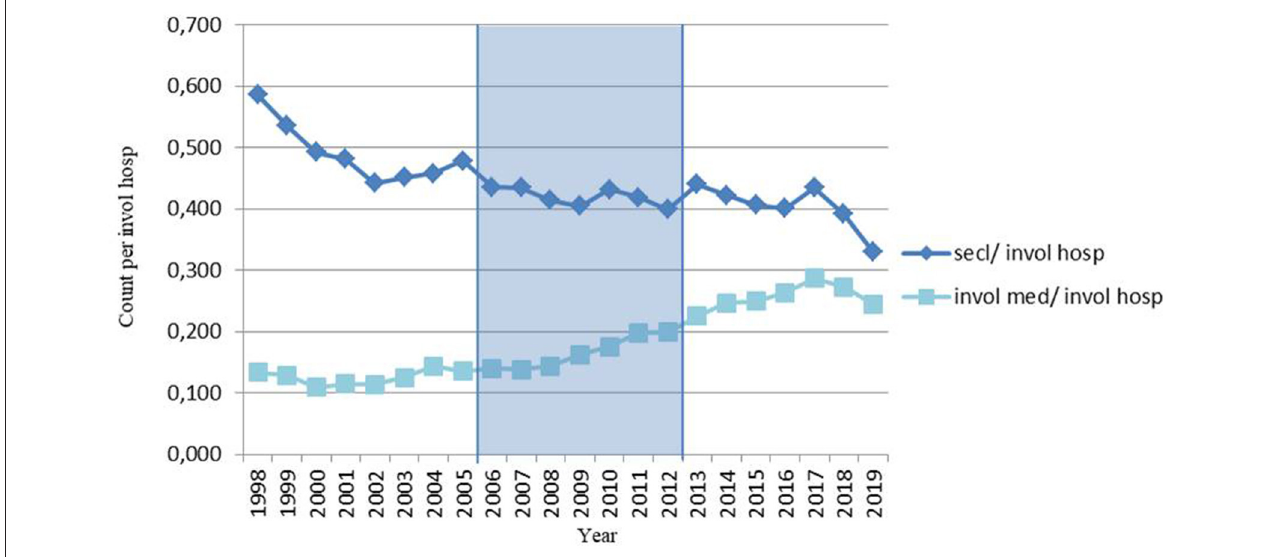
FIGURE 2 | Number of seclusions and involuntary medications per involuntary hospitalization in the Netherlands per year, before (1998–2005), during (2006–2012) and after (2013–2019) a nationwide program to reduce the use of